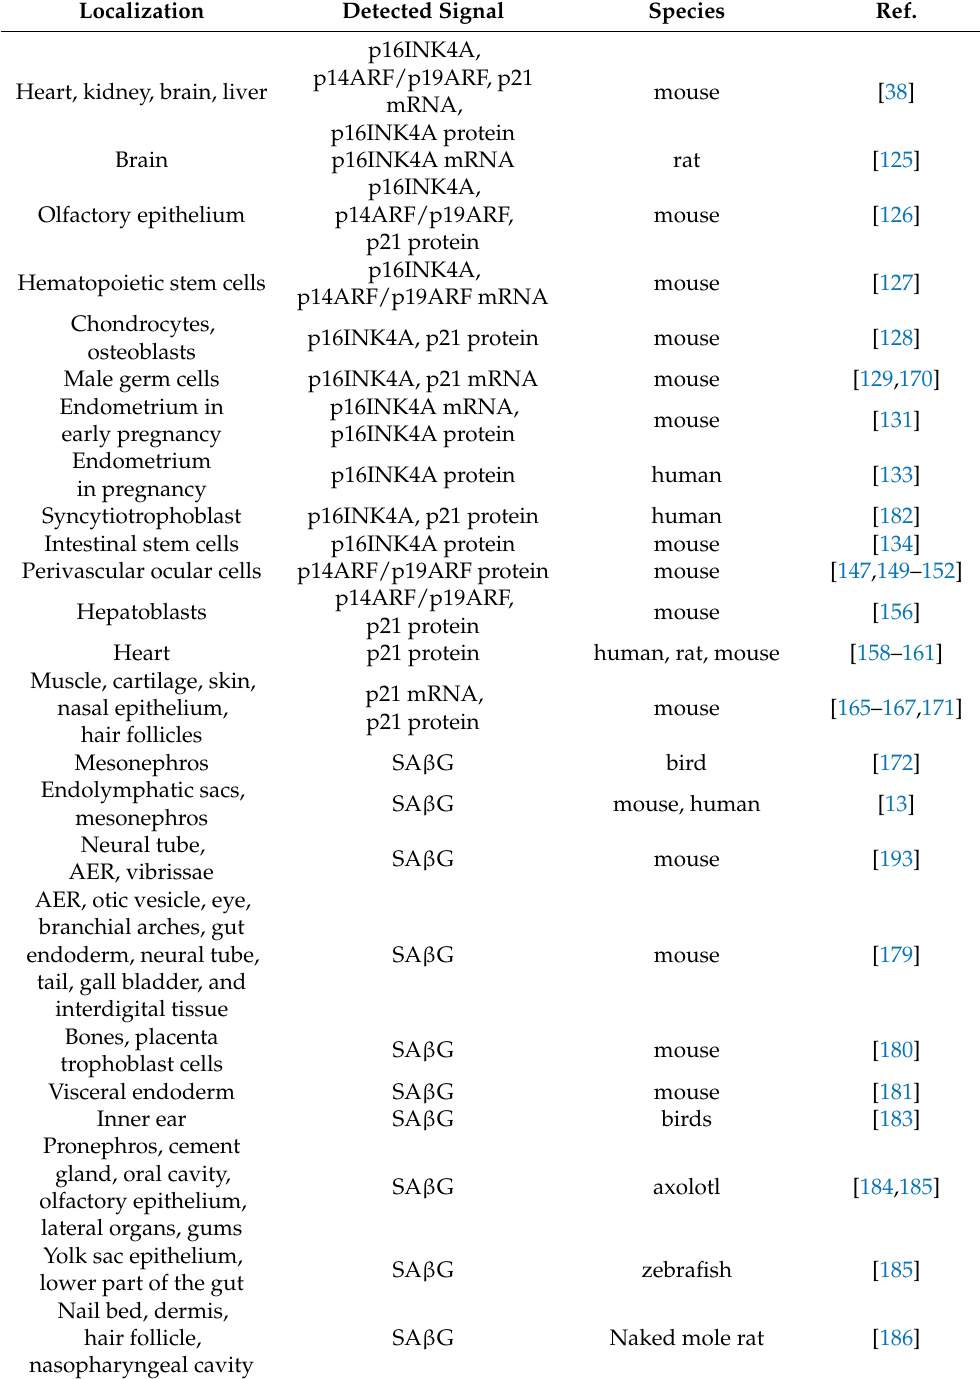
Table 1. Detection of senescence markers during